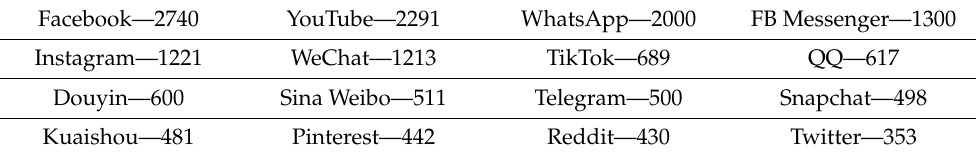
Table 1. Social media platforms and registered users in January 2021